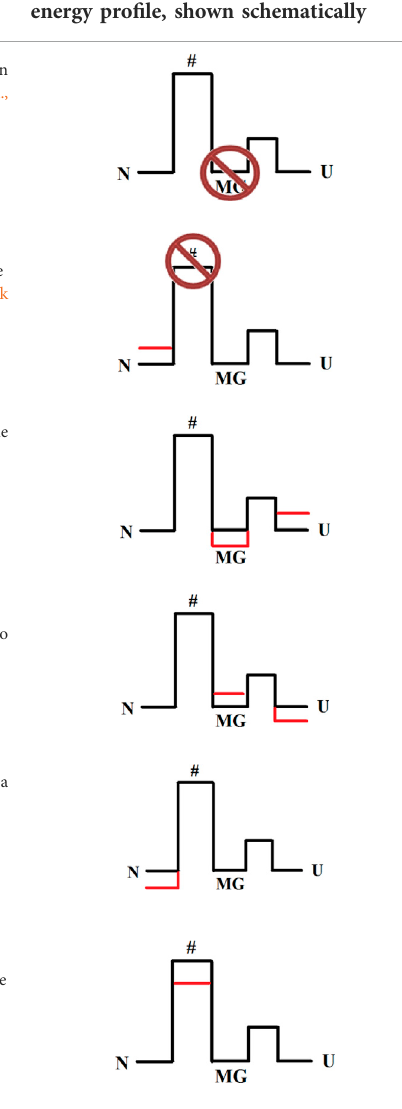
Experimentally established effects of substitutions on